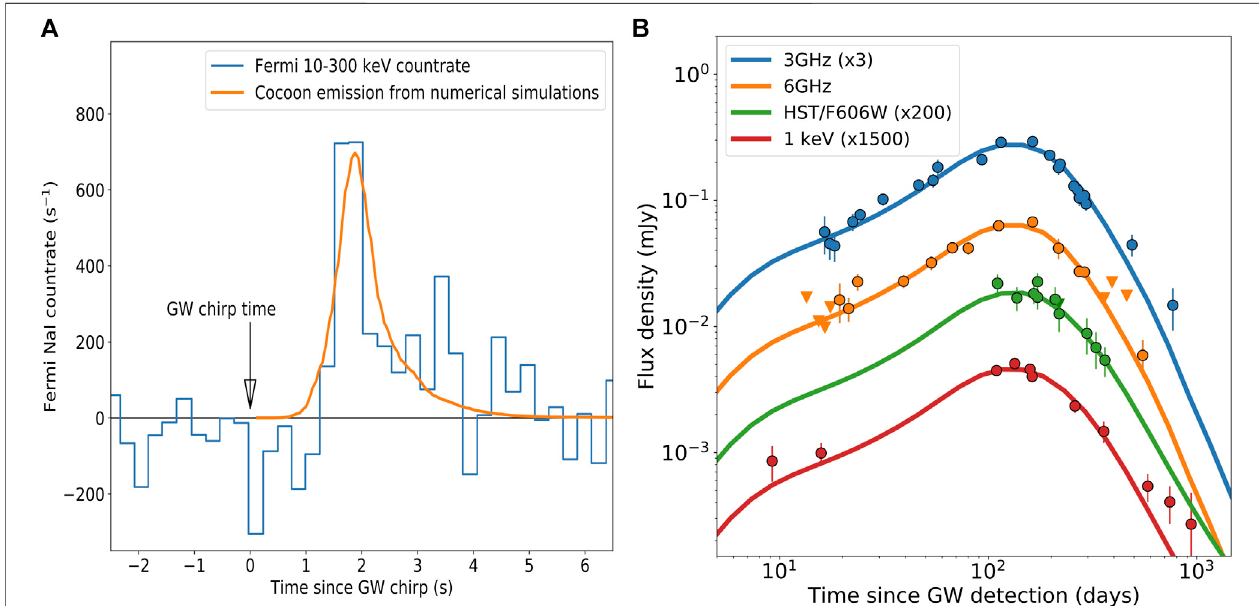
FIGURE 2 | Left panel (A) : the prompt emission of GW170817. The blue step-line shows the Fermi data (Goldstein et al., 2017), while the orange solid line is the prediction from a theoretical simulationthat assumes astructured out fl ow from thejet-wind interaction(Lazzati et al., 2017b).The radiation is assumed to bereleasedat thephotosphere. Rightpanel(B) :AfterglowofGW170817.Symbolswitherror-barsshowobservationsintheradio,optical,andX-raybands.Solidlinesshowthebest (cid:2) 35 ° from the line of sight. Additional data at different radio frequencies fi t result for an afterglow model with a structured out fl ow and an observer located at θ o were used to constrain the model, but only two radio bands are shown for clarity. Adapted from Makhathini et al.